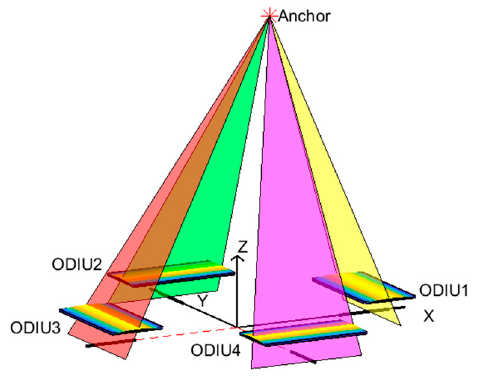
Figure 2. Schematic of the POS.